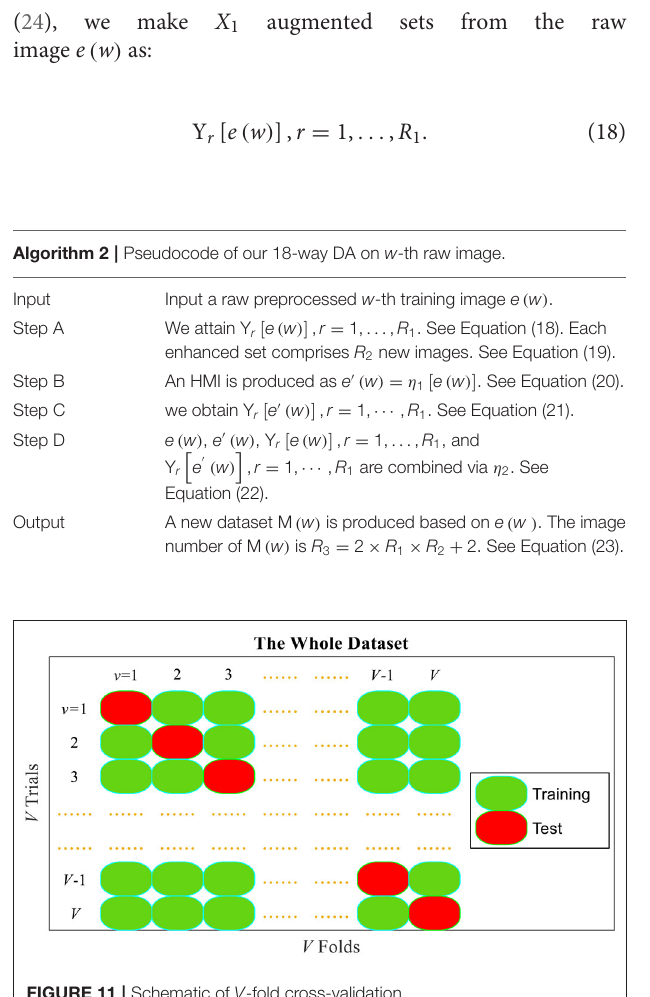
FIGURE 11 | Schematic of V -fold cross-validation.